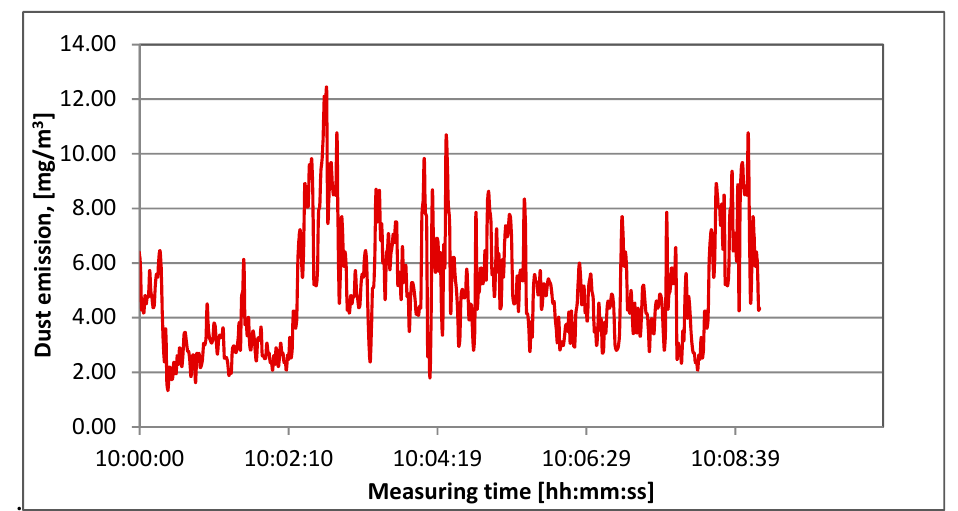
Figure 16. Dust generation for irregular particles—feed material 𝑥̅ = 4.91, s = 1.84 .